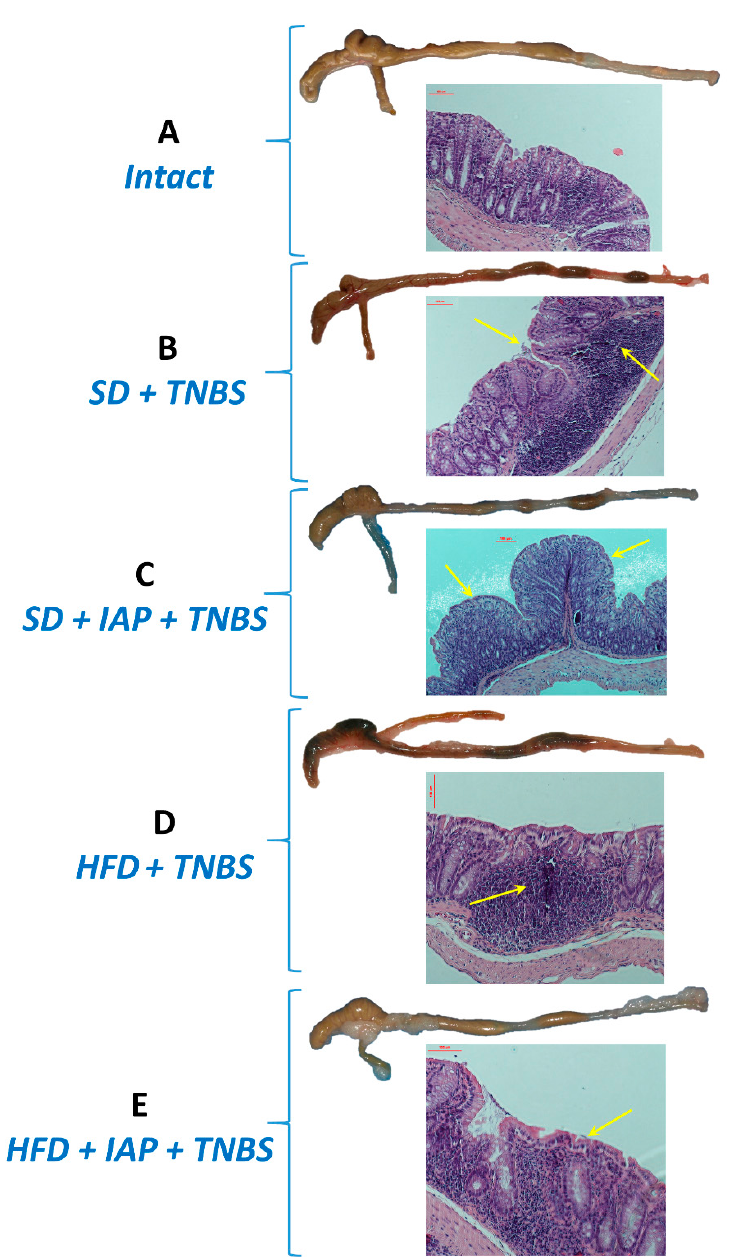
Figure 2. The representative gross (upper panel) and microscopic (lower panel) appearance of colon from intact mouse ( A ), sedentary mouse with TNBS colitis fed standard diet (SD) ( B ), sedentary mouse fed SD with colitis treated with IAP with voluntary exercise on wheels ( C ), sedentary mouse fed HFD with colitis ( D ) and mouse fed HFD with colitis treated with IAP with voluntary exercise on wheels ( E ). In mice fed SD or HFD with colitis, the enterocyte architecture is distorted, revealing edema and infiltration of mucosa and submucosa with inflammatory cells, destroyed crypts, extended ulcerations and transmural inflammatory cell infiltrates ( B , D ) (arrows) as compared with exercising mice fed either with SD or HFD treated with IAP ( C , E ). Treatment with IAP, especially in HFD exercising mice, led to partial restoration of colonic mucosal lining (arrows), partial preservation of enterocyte structure, low levels of epithelial damage and less severe inflammatory cell infiltration of the colonic mucosa and submucosal